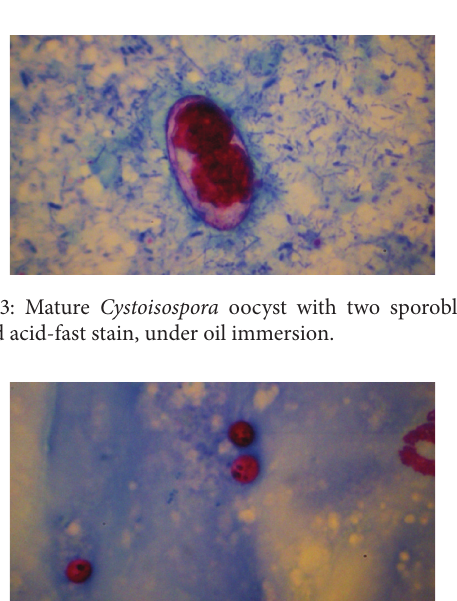
Figure 2: Immature Cystoisospora oocyst on modified acid-fast stain, under oil immersion.